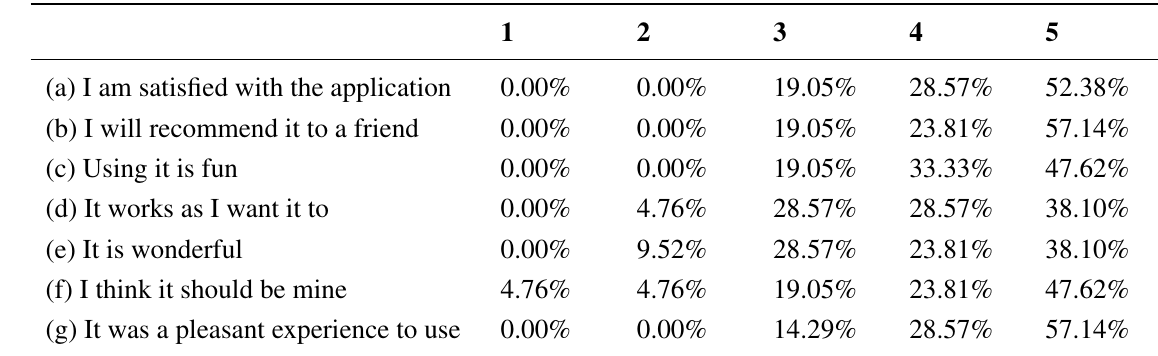
Table 6. Results in terms of satisfaction